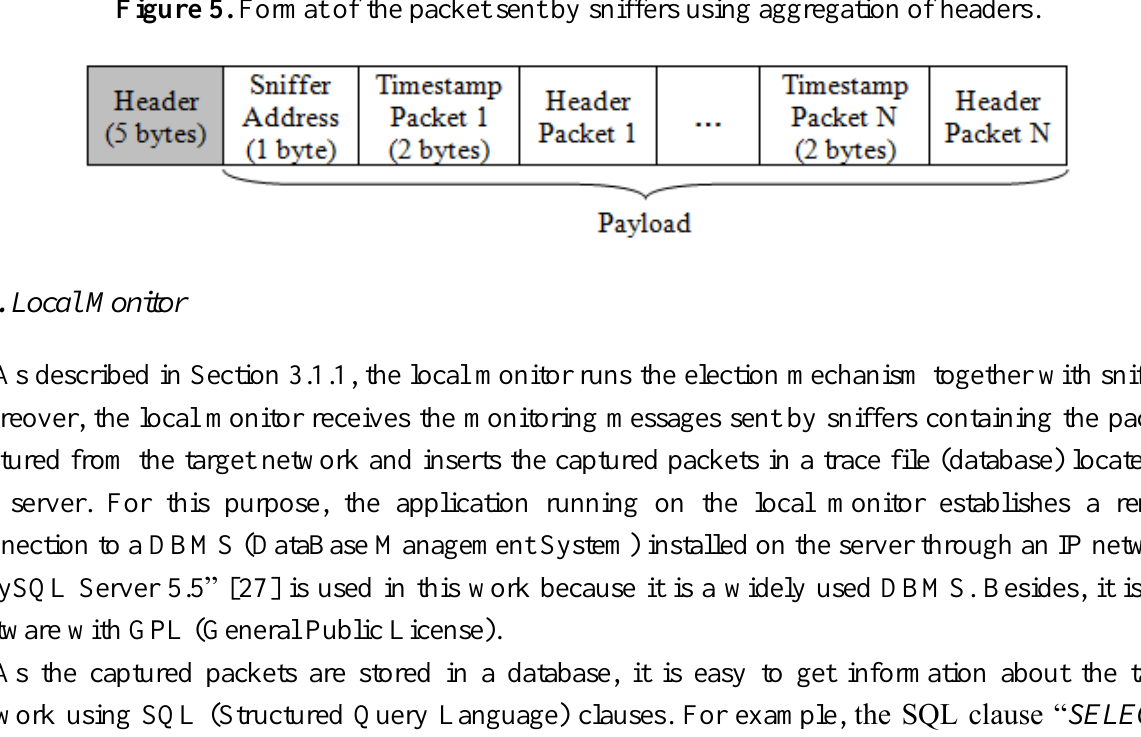
Figure 5. Format of the packet sent by sniffers using aggregation of